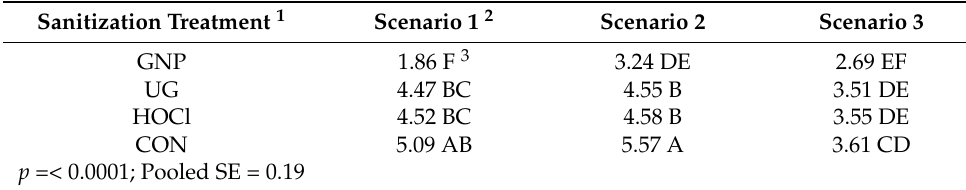
Table 2. Salmonella typhimurium survivors (log 10 CFU/cm 2 ) on tomato skin samples by the sanitization treatment × experimental contamination/sanitization scenario